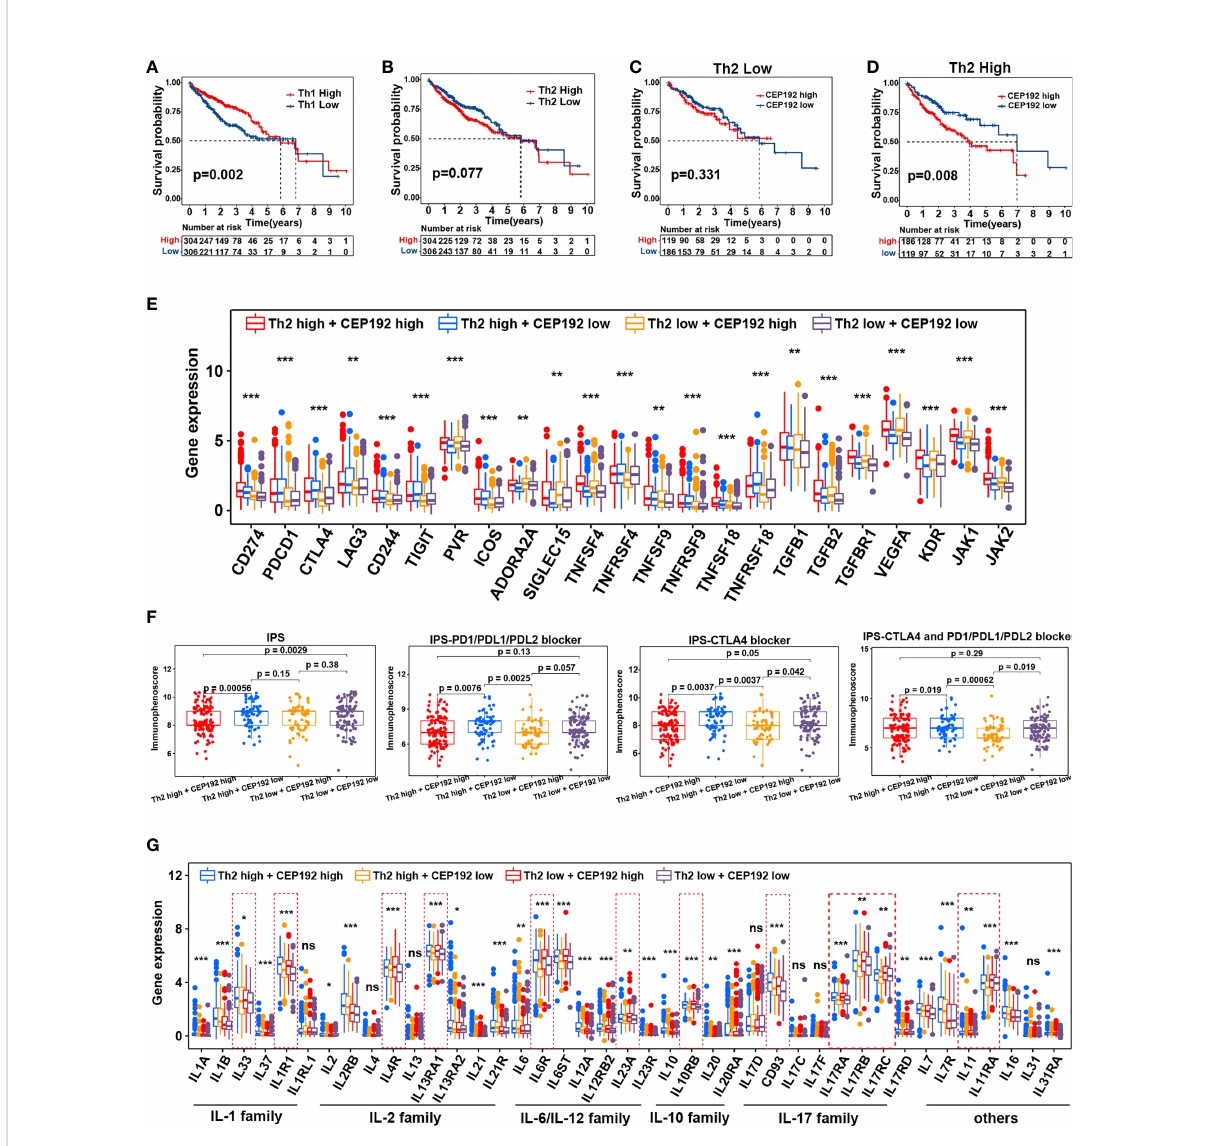
FIGURE 7 Correlation analysis of CEP192 expression with immunotherapy response and in fl ammatory cytokine levels. (A) Kaplan – Meier curves showing the survival difference in the patients with low versus high levels of Th1 cells (Th1 Low, n = 306; Th1 High, n = 304). Log-rank (Mantel-Cox) test. (B) Kaplan – Meier curve showing the survival difference between Th2 high ( n = 304) and Th2 low groups ( n = 306). Log-rank (Mantel-Cox) test. (C) Kaplan – Meier curve showing the survival difference between CP192 high ( n = 119) and CP192 low ( n = 186) groups in HCC patients with low in fi ltration of Th2 cells. Log-rank (Mantel-Cox) test. (D) Kaplan – Meier curve showing the survival difference between CP192 high ( n = 186) and CP192 low ( n = 119) groups in HCC patients with high in fi ltration of Th2 cells. Log-rank (Mantel-Cox) test. (E) Expression of 23 immune checkpoints in the Th2 high + CEP192 high ( n = 186), Th2 high + CEP192 low ( n = 119), Th2 low + CEP192 high ( n = 119), and Th2 low + CEP192 low ( n = 186) groups. Mean ± SEM, Kruskal – Wallis test, ** p <0.01, *** p <0.001. (F) Comparison of IPS, IPS-PD1/PD-L1/PD-L2 blocker, IPS-CTLA4, and IPS-CTLA4 + PD1/PD-L1/PD-L2 blocker scores of Th2 high + CEP192 high ( n = 127), Th2 high + CEP192 low ( n = 71), Th2 low + CEP192 high ( n = 62), and Th2 low + CEP192 low ( n = 110) groups in HCC patients from TCGA-LIHC. Mean ± SEM, Kruskal – Wallis test. (G) Expression of interleukins and associated receptors in the Th2 high + CEP192 high ( n = 186), Th2 high + CEP192 low ( n = 119), Th2 low + CEP192 high ( n = 119), and Th2 low + CEP192 low ( n = 186) groups based on HCC patients from TCGA-LIHC ( n = 371) and ICGC-LIRI-JP ( n = 240) datasets. Mean ± SEM, Kruskal – Wallis test, * p <0.05, ** p <0.01, *** p <0.001. NS, non signi fi